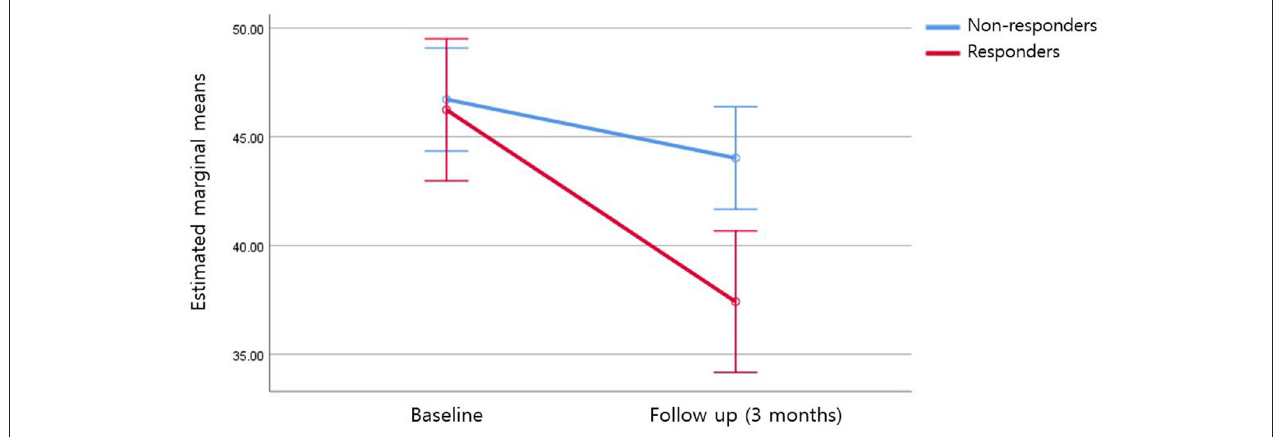
FIGURE 1 | Negative beliefs about the uncontrollability and danger of worry at